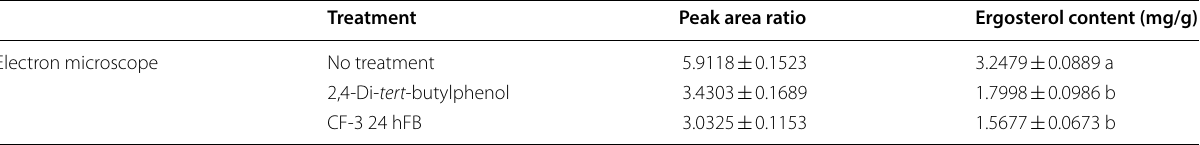
The mean and standard error in the table were taken from three replicates, and the different letters indicated that the different treatments of the same strain had significant differences ( P < 0.05